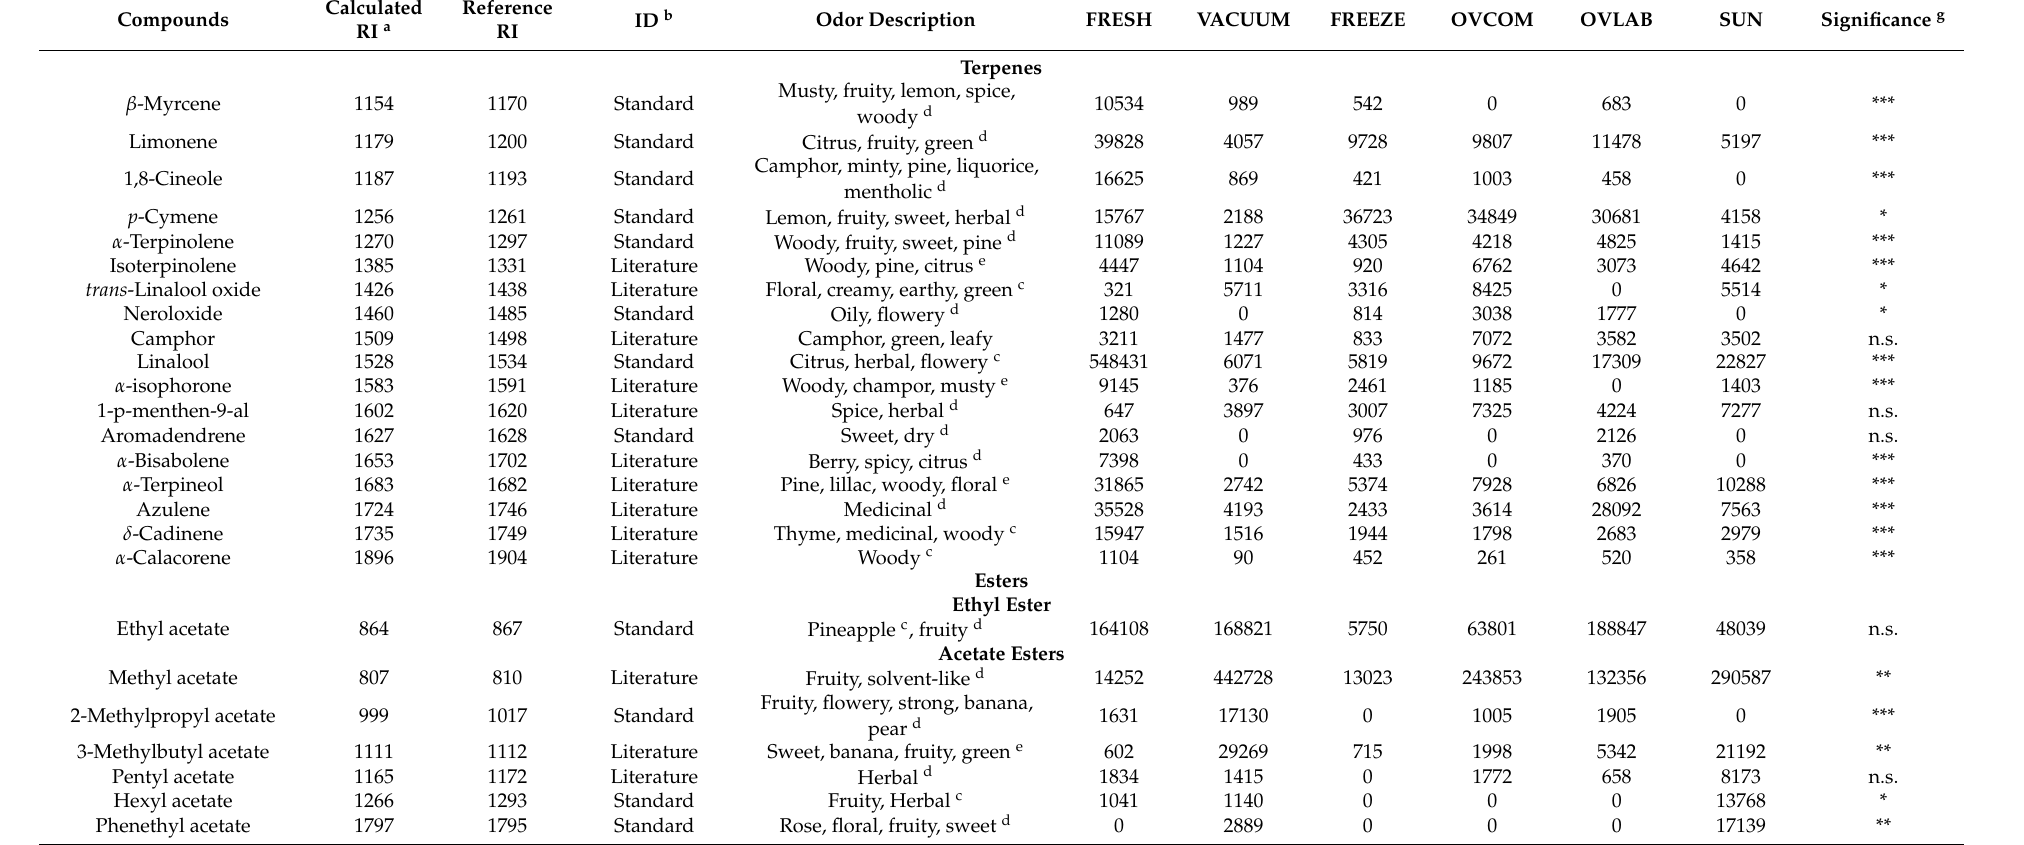
Table 2. Volatile compounds (peak areas relative to dry matter content) identified in the fresh and dried roselle ( Hibiscus sabdariffa L.) calyx using different drying